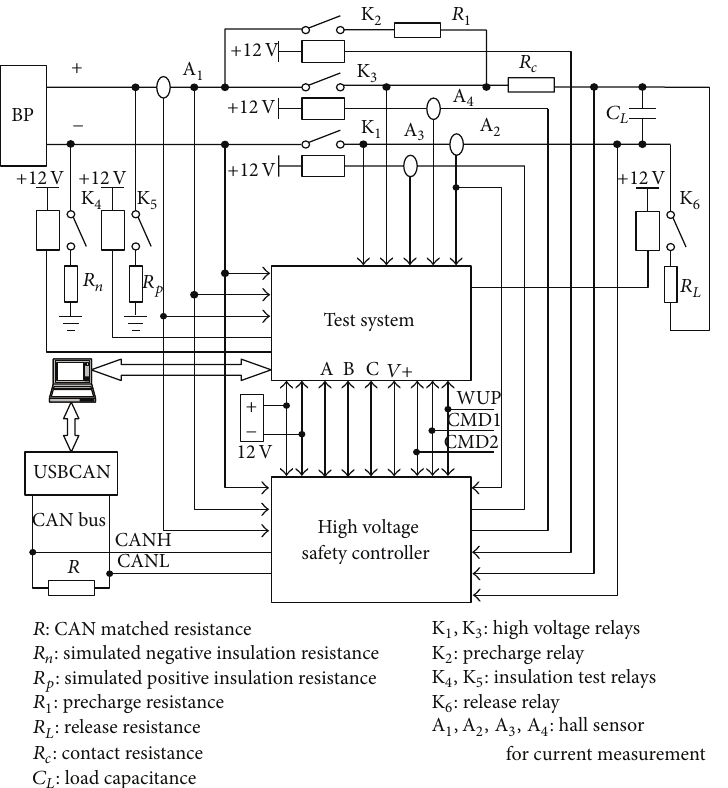
Figure 14: Circuit structure schematic diagram of high voltage safety test.